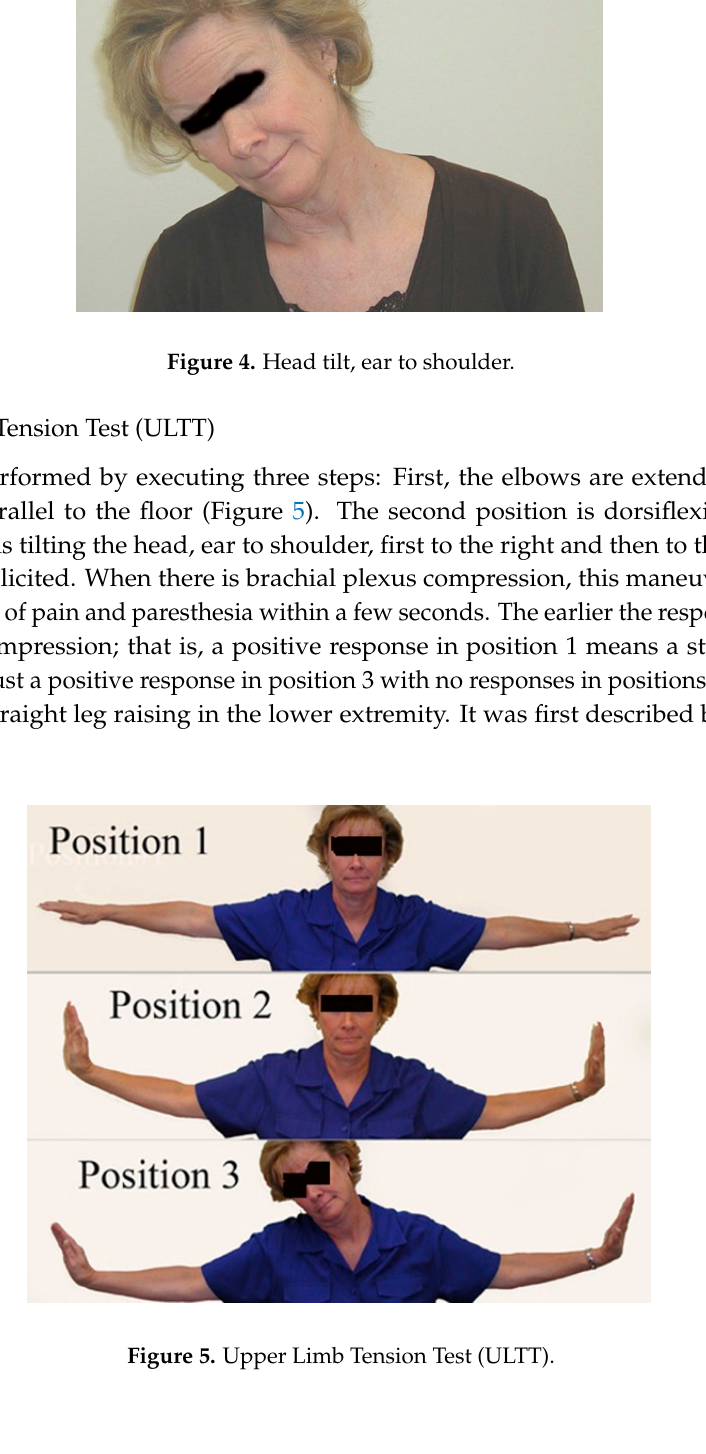
Figure 5. Upper Limb Tension Test (ULTT).